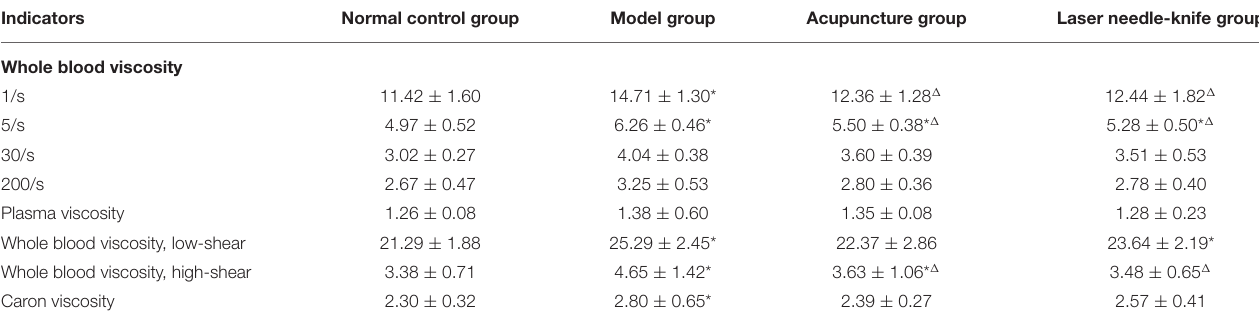
TABLE 2 | Hemorheology indicators( ¯ x ± s) (m · Pa/s).